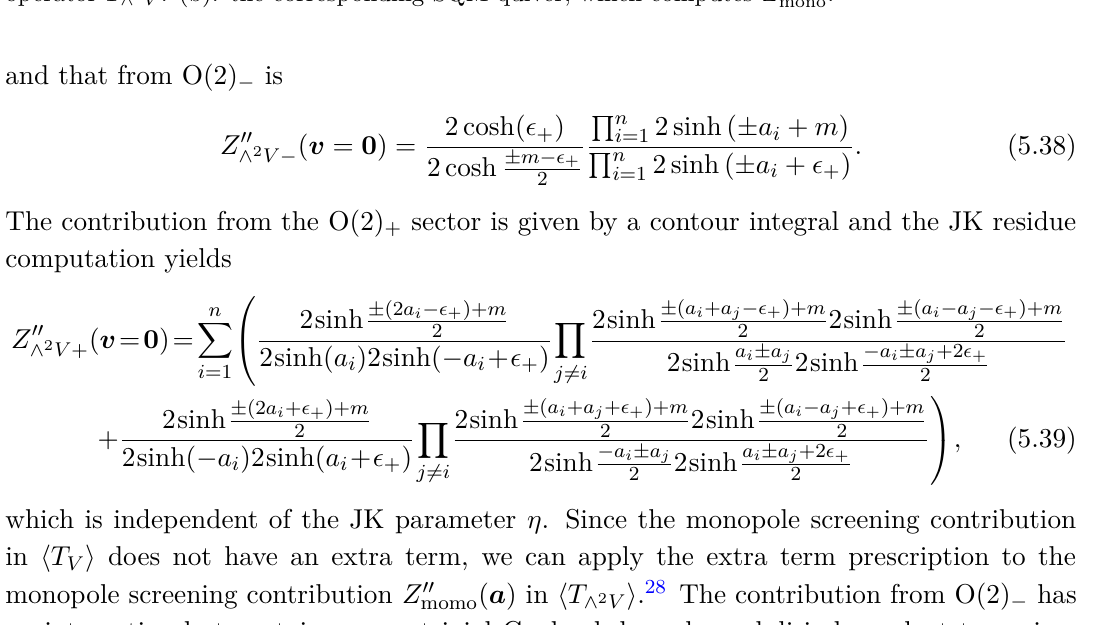
Figure 24. (a): the brane configuration for the monopole screening sector v = 0 of the ’t Hooft operator T . (b): the corresponding SQM quiver, which computes Z 00 ∧ 2 V